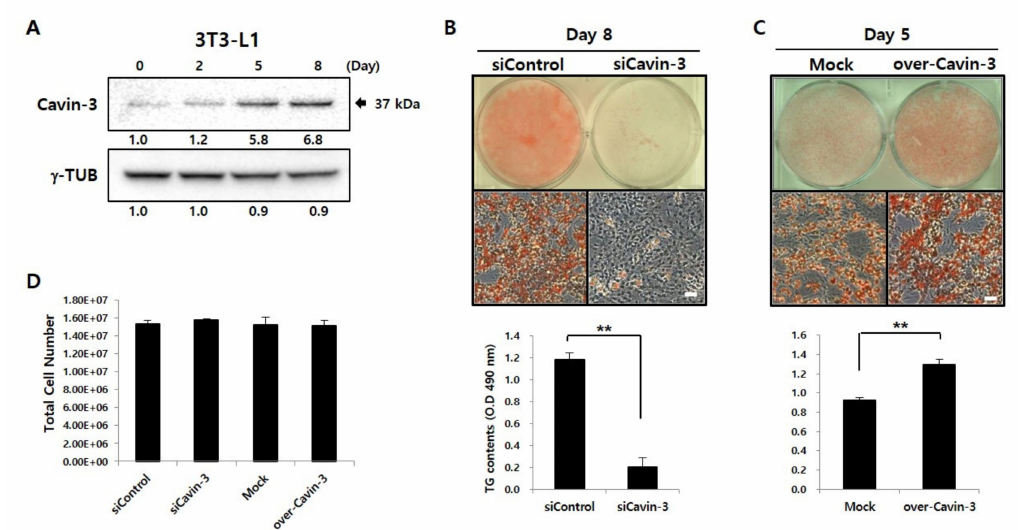
Figure 1. Caveolae-associated protein 3 (Cavin-3) profiling during adipogenesis and Cavin-3 based control of adipocyte di ff erentiation. ( A ) Expression of Cavin-3 protein during adipocyte di ff erentiation. 3T3-L1 cells were di ff erentiated for 8 days and harvested at various time points (days 0, 2, 5, and 8). Anti-gamma tubulin ( γ -TUB) antibody was used as a control and the grouping of blots cropped from di ff erent gels. ( B , C ) The Oil Red O (ORO) staining and total glyceride (TG) content were validated in siCavin-3 and over-Cavin-3 cells after 8 and 5 days of di ff erentiation, respectively. Scale bar = 200 µ m. The TG content was quantified by Sudan II staining the cells ( n = 3) by measuring the absorbance at 490 nm. The data are presented as the means ± SD. (* p < 0.05, ** p < 0.01; data were analyzed with an unpaired Student’s t -test). ( D ) Total cell number was counted in siControl, siCavin-3, Mock, and over-Cavin-3 cells at day 8 of di ff erentiation. The data are presented as the means ±